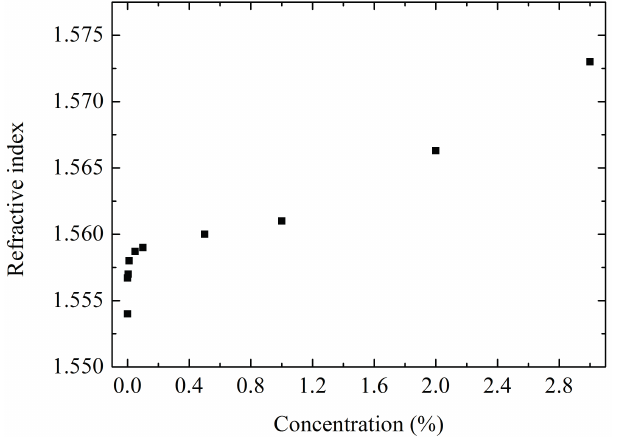
composite concentrations and 8 min 2